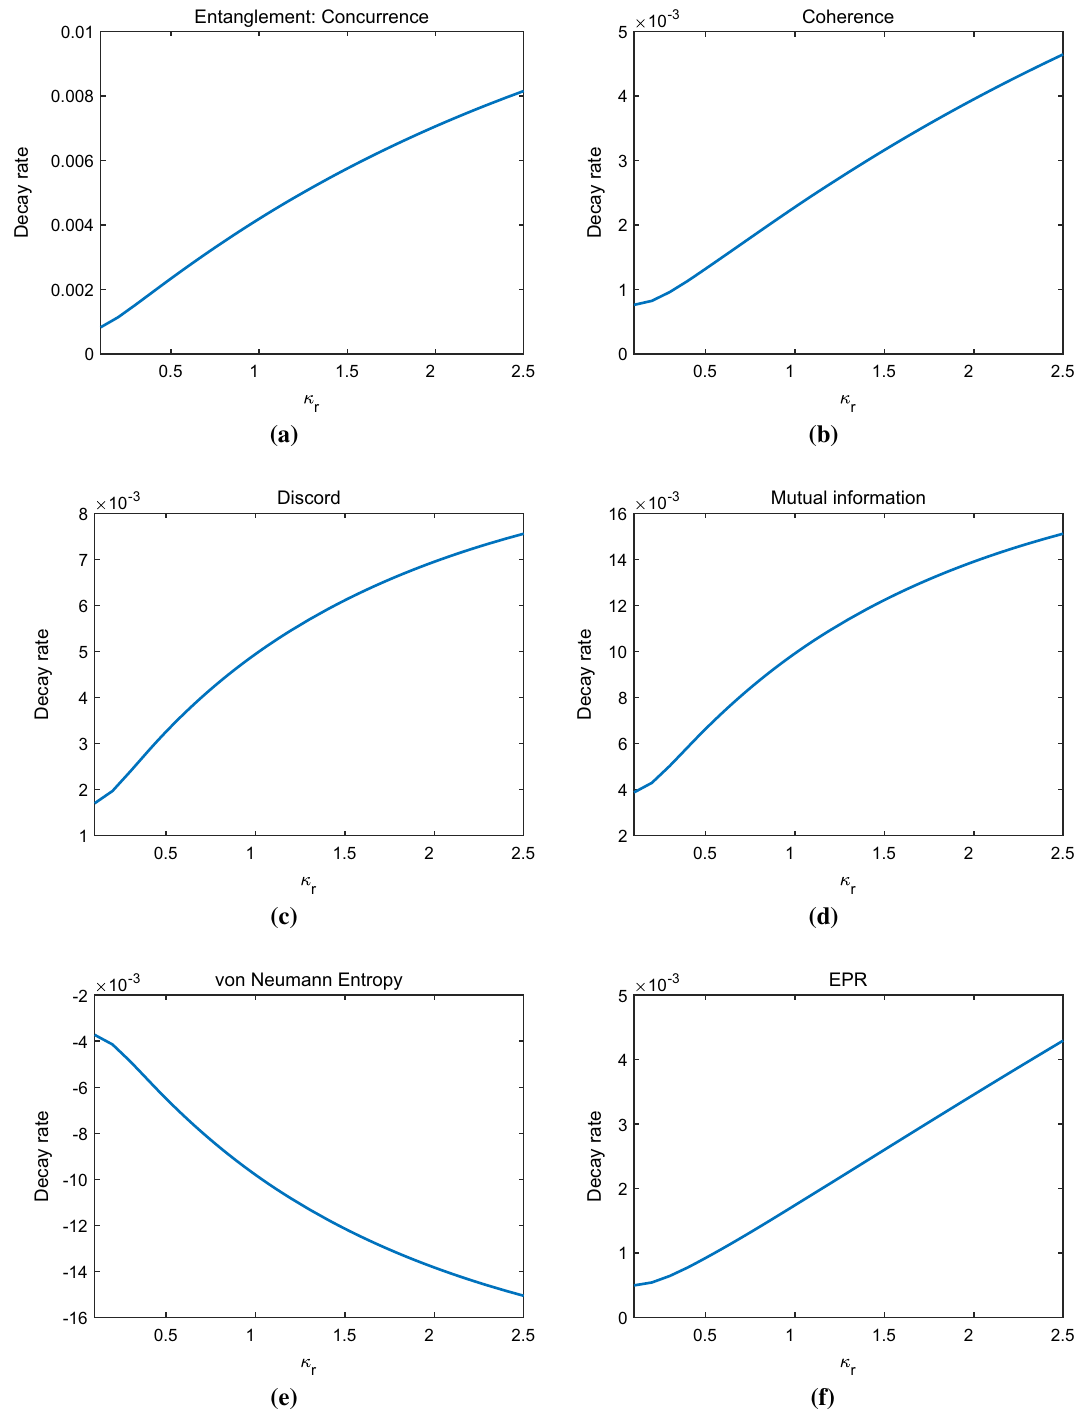
Fig. 11 The decay rates of the quantum correlations with respect to the local acceleration or curvature κ r when t = 100 μ same as those in Fig.